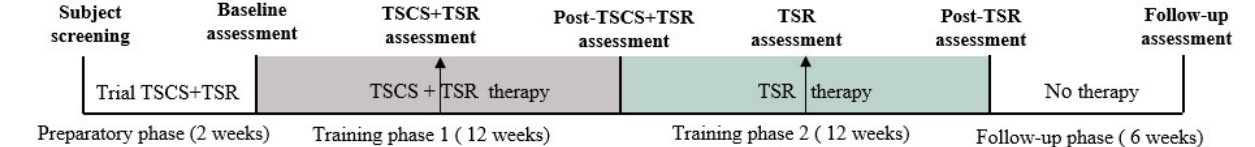
Figure 1. The outline of the study, divided into four phases: (i) The preparatory phase, in which par- ticipants were enrolled and screened to ensure their eligibility for the study. During this period, their response to TSCS was tested and optimal stimulation settings were determined. The visual analog scale was used to record their response to the stimulation. After completing a baseline assessment over a period of 2 weeks, the participants received two phases of therapy, each lasting for 12 weeks, with two half-way assessments completed every 6 weeks. (ii) Training phase 1, transcuta- neous electrical spinal cord stimulation (TSCS) with task-specific rehabilitation (TSR); (iii) training phase 2, TSR alone; and (iv) the follow-up phase, during which no therapy was performed, and assessments were repeated 6 weeks following the completion of the TSR training period.